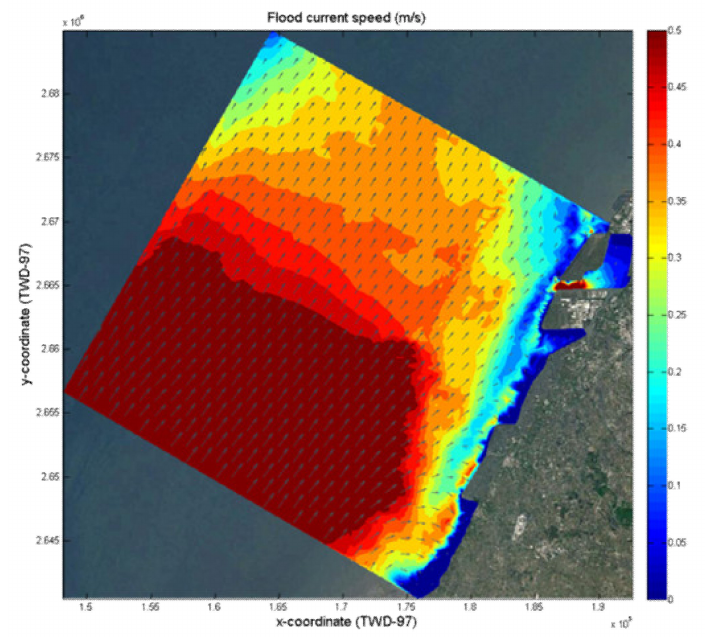
Figure 4. Current velocity and direction during flood tides.